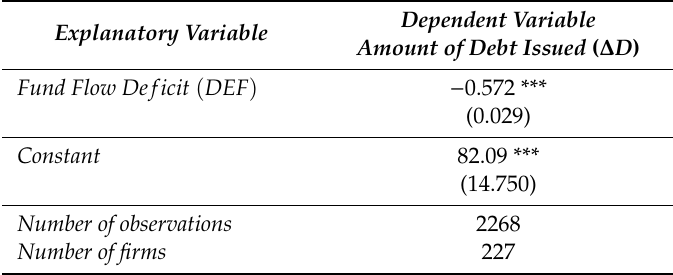
Table 2. Estimation results of the pecking order model.